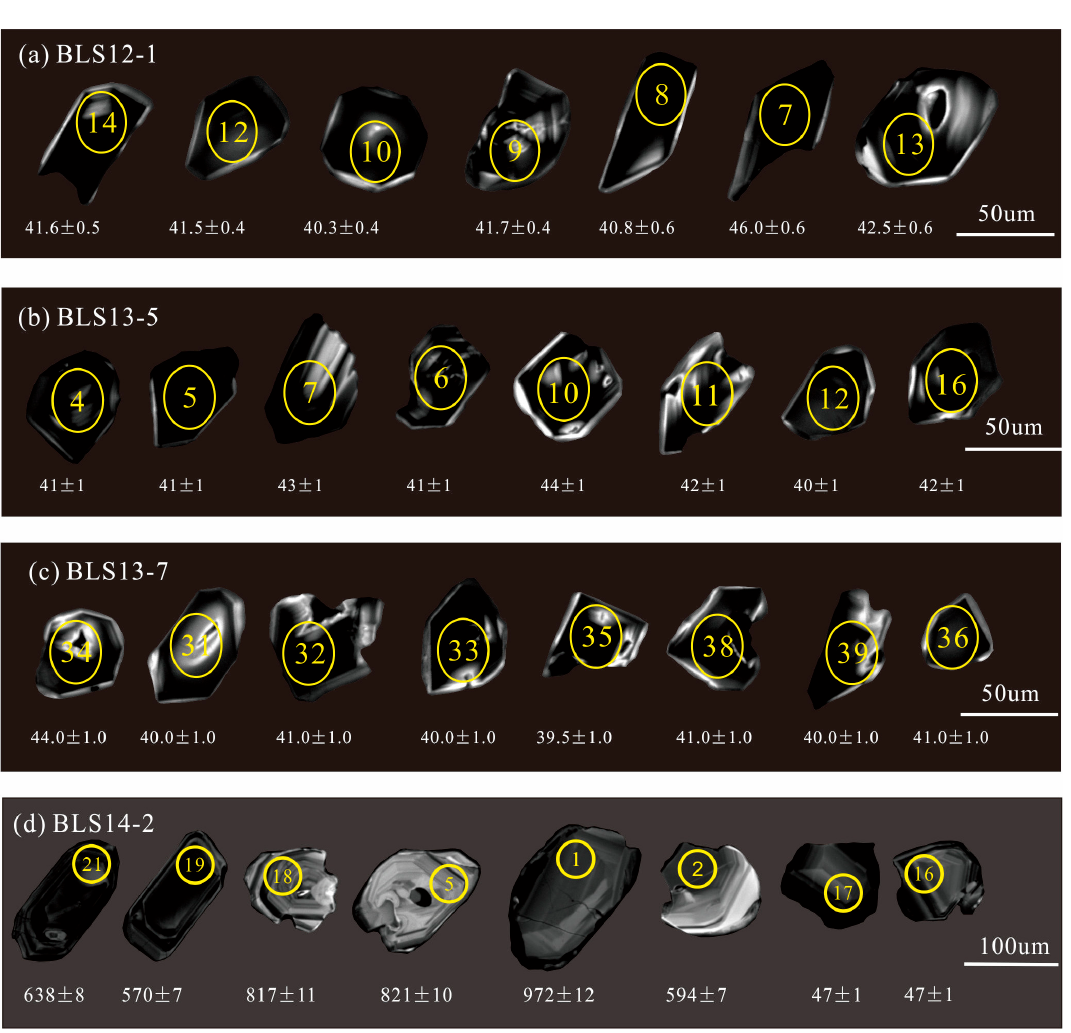
Figure 4. Representative cathodoluminescence (CL) images of selected zircons from the Cenozoic mafic rocks in the Qianjiadian region.